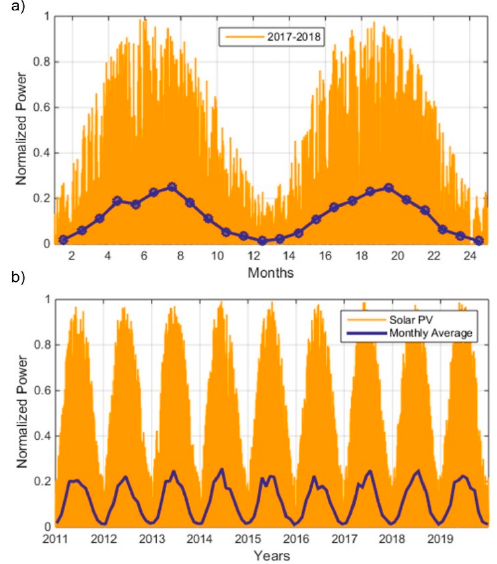
Figure 3. Profile of solar-PV power in the UK: ( a ) in the period 2017–2018; ( b ) normalized historical data. Data from [30,31].